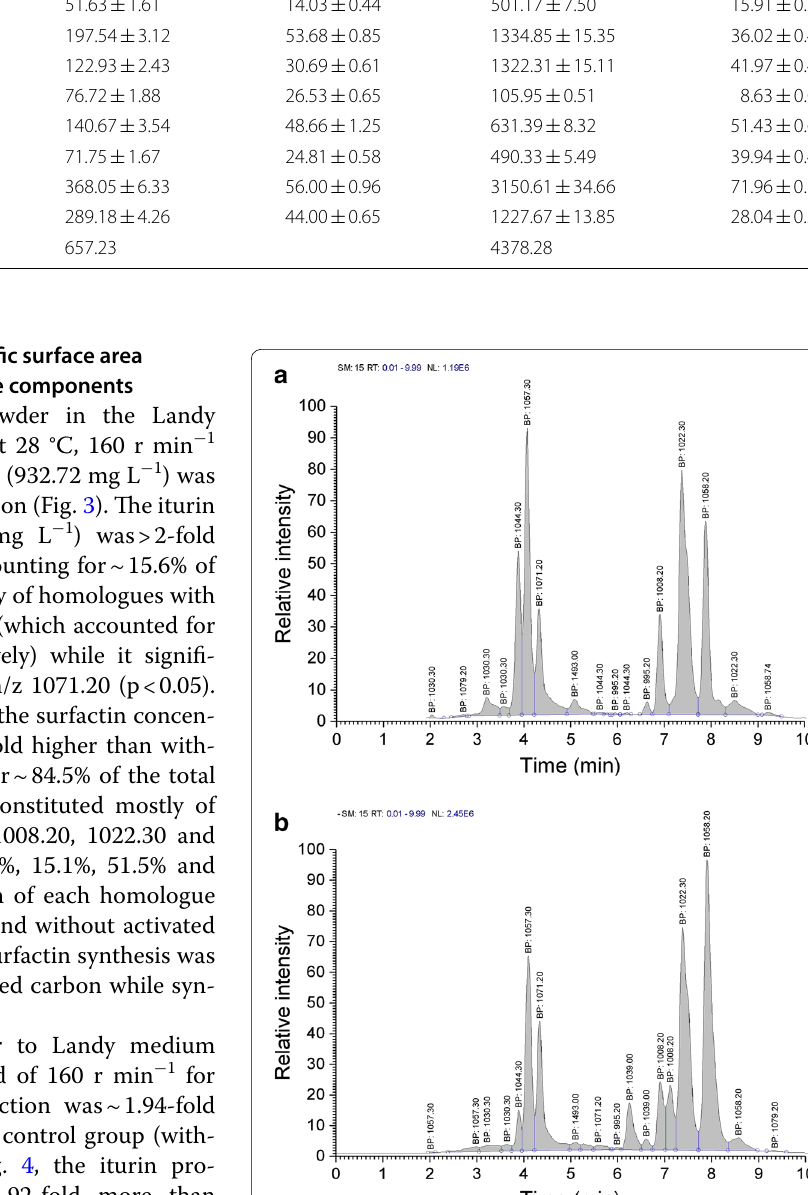
Fig. 3 Ion chromatogram of iturin and surfactin homologues produced by liquid-state fermentation ( a ), and solid-state fermentation ( b